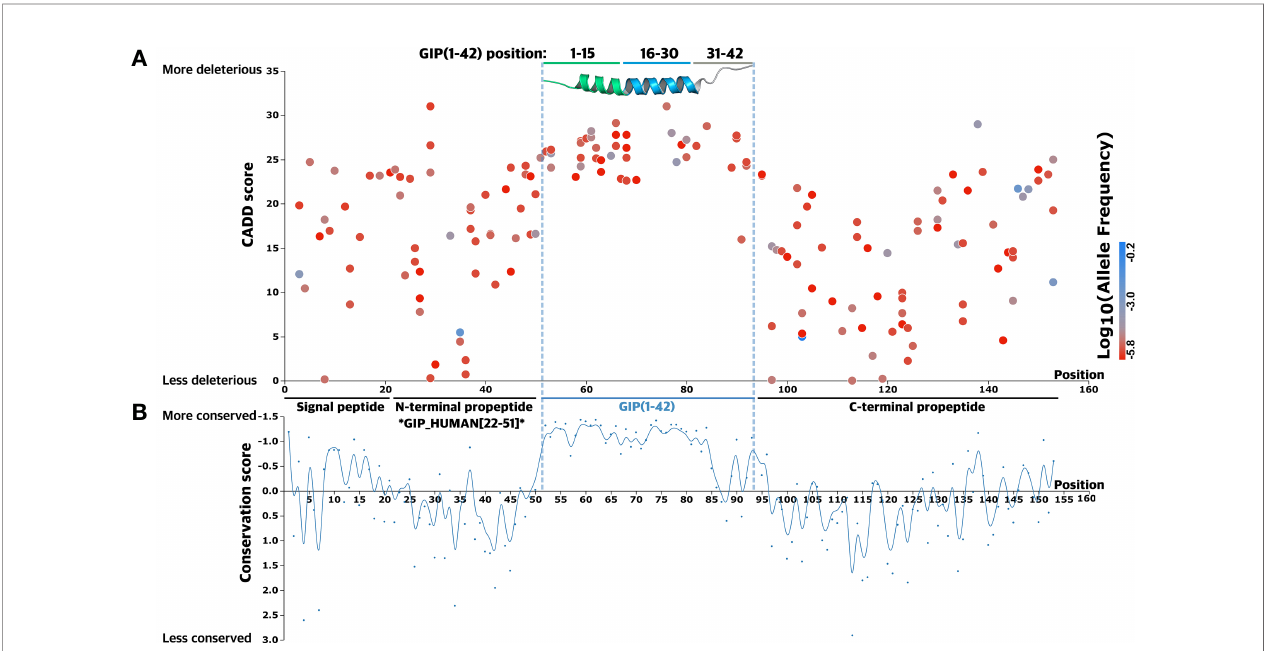
FIGURE 2 | Mutational spectrum of GIP gene missense variants. (A) A total of 168 glucose-dependent insulinotropic polypeptide (GIP) gene missense variants were mapped according to their amino acid position. A Combined Annotation-Dependent Depletion (CADD) score, predicting variant deleteriousness, was employed to establish a link between mutations and regions of particular importance in the precursor hormone. The GIP peptide is highlighted in blue and visualized by an experimental 3D structure (PDBid: 2OBU) (53), N-terminal segment (green), core segment (blue), C-terminal segment (grey). The corresponding variant allele frequency is colored by a gradient scale with more frequent variants (blue) and less frequent variants (red). (B) The bottom graph displays the conservation score at each alignment positions as obtained from ConSurf (54) to determine functionally important segments of the precursor hormone. A lower conservation score displays more conserved amino acid sites, indicating the GIP peptide sequence is more conserved across species (all metazoan, including